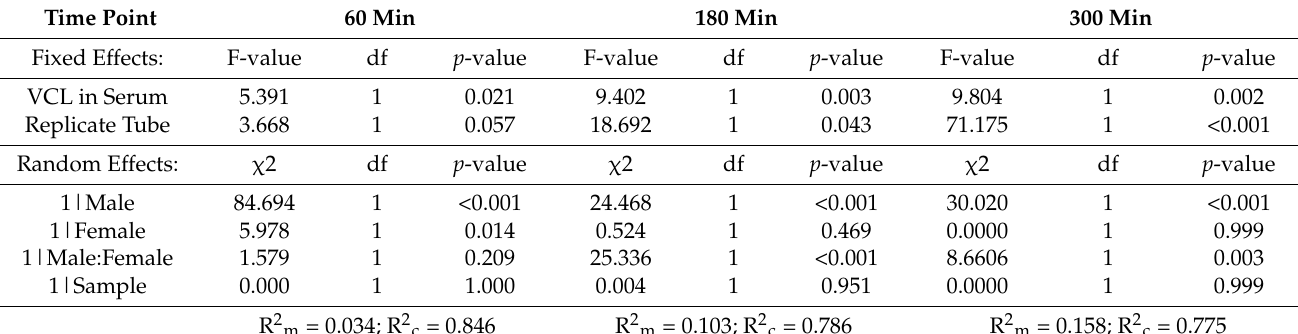
Table 2. Time point-specific linear mixed models (LMM) testing for the association between sperm swimming velocity (VCL) in follicular fluid (response variable) and serum. Models included VCL in serum treatment and replicate tube as fixed effects and male, female, male:female interaction, and repeated measurement of each tube (sample) as random effects. R 2 m: marginal R 2 —proportion of variance explained by fixed factors; R 2 c: conditional R 2 —proportion of variance explained by fixed and random